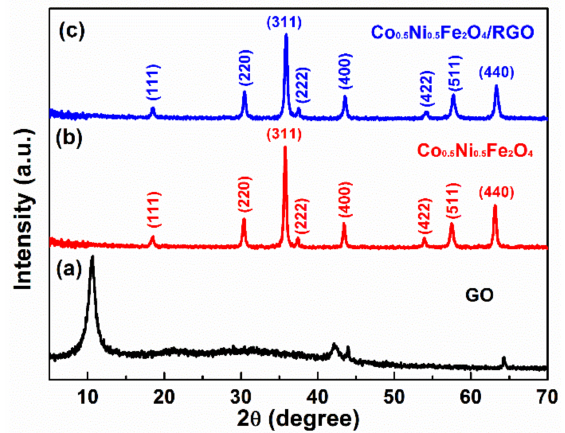
Figure 1. XRD patterns of the samples: ( a ) GO; ( b ) Co 0.5 Ni 0.5 Fe 2 O 4 fibers; ( c ) Co 0.5 Ni 0.5 Fe 2 O 4 fibers/RGO